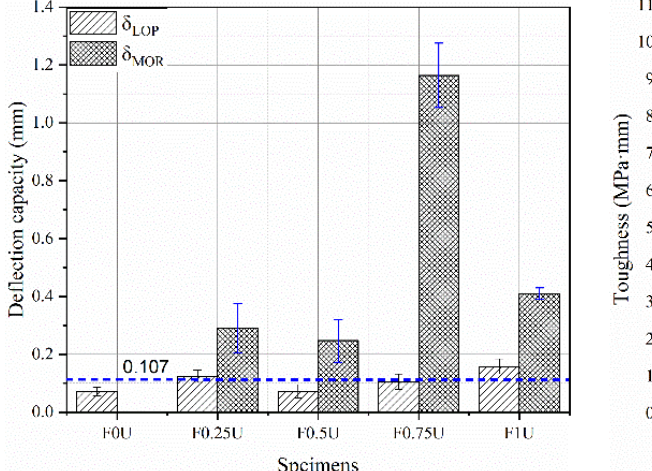
Figure 7. The relationship between flexural strength and toughness.